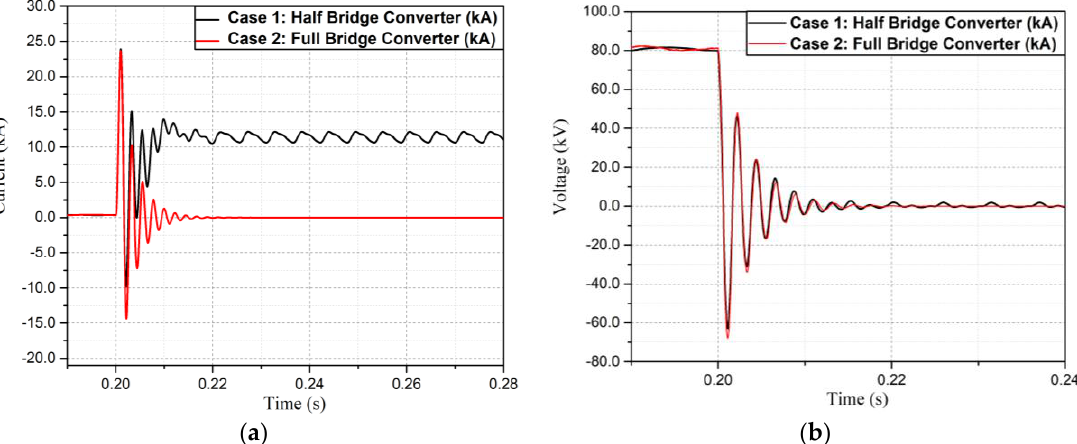
Figure 7. Simulation of a DC pole-to-ground fault with MMCs: ( a ) current waveform in the transient state; ( b ) voltage measured at converter terminals.